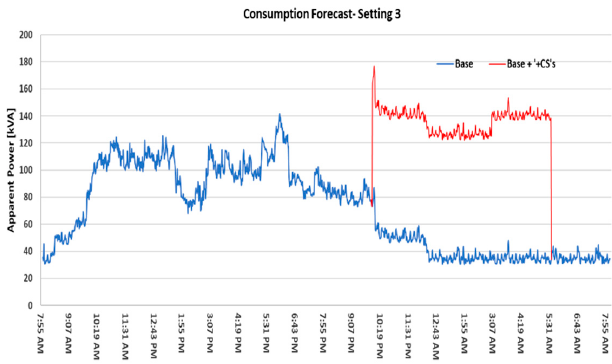
Figure 8. Consumption Forecast—Setting 3.